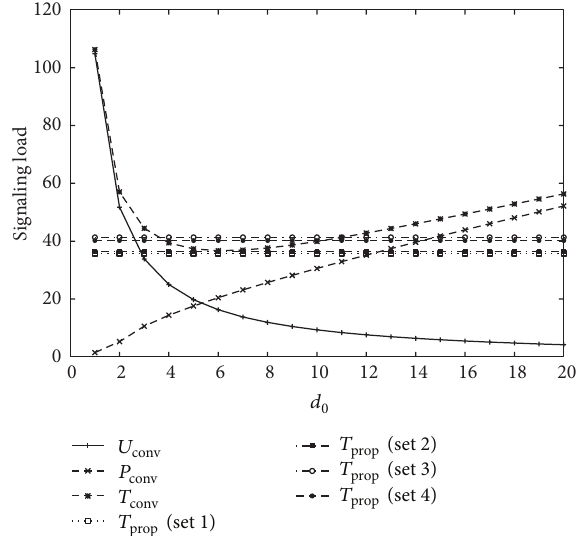
Figure5:Signalingloadfor 1/𝜆 𝑐 = 10.5∗2/3600(ℎ) (highmobility), 1/𝜆 = 10.5 ∗ 100/3600(ℎ) (short intersession idle period).